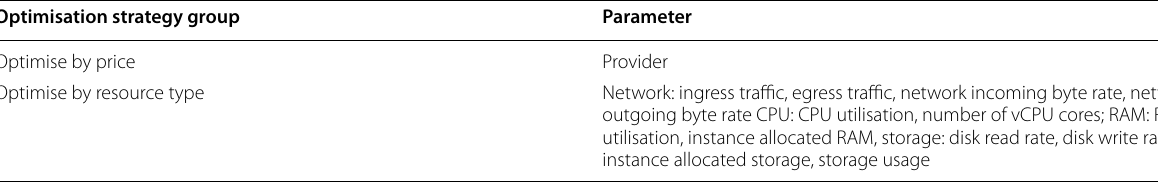
Table 2 Application service and cloud environment parameters according to the optimisation strategy groups Optimisation strategy